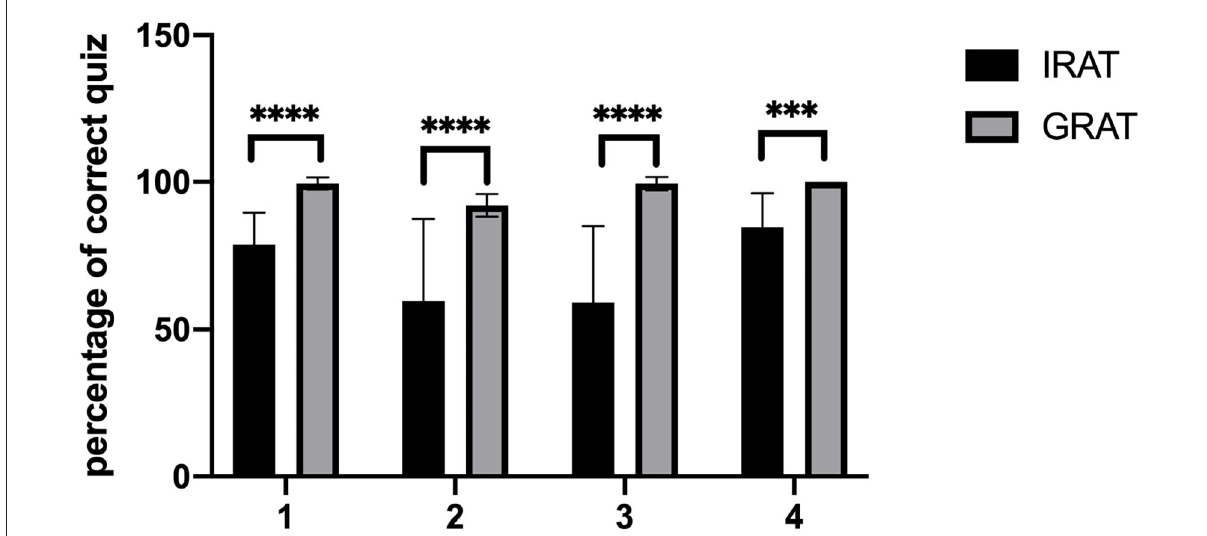
FIGURE2 The score of the group readiness assurance test (GRAT) and the individual readiness assurance test (IRAT). *** P < 0.001, **** P < 0.0001 between the two compared groups by unpaired t test.